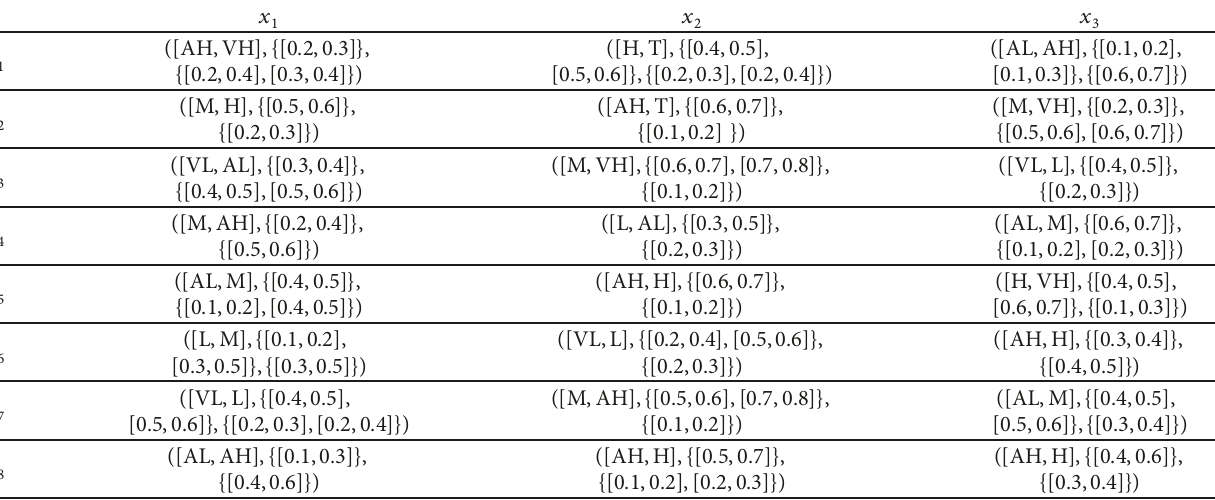
̃𝑅 in the form of IVDHF UUBLS.